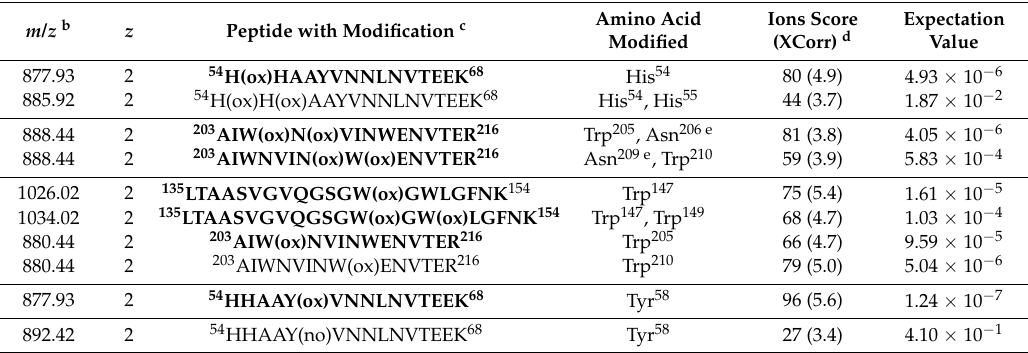
Table 2. The modified (oxidized and nitrated) amino acid residues in MNSOD a